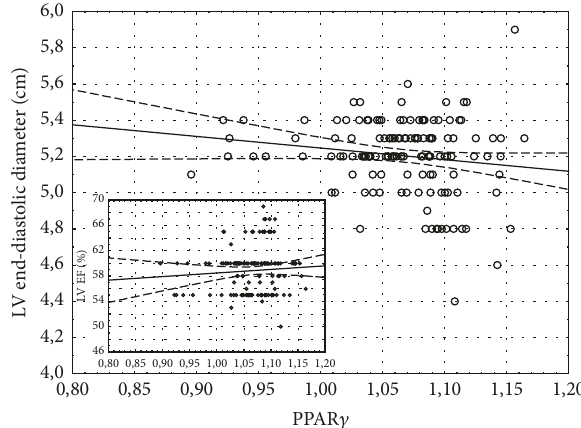
Figure 3: There were no significant correlations between PPAR 𝛾 and either left ventricular end-diastolic dimension ( 𝑅 = −0.11 , 𝑝 = NS, the main graph) or left ventricular ejection fraction (LVEF; 𝑅 = 0.05 , 𝑝 = NS, small graph) after